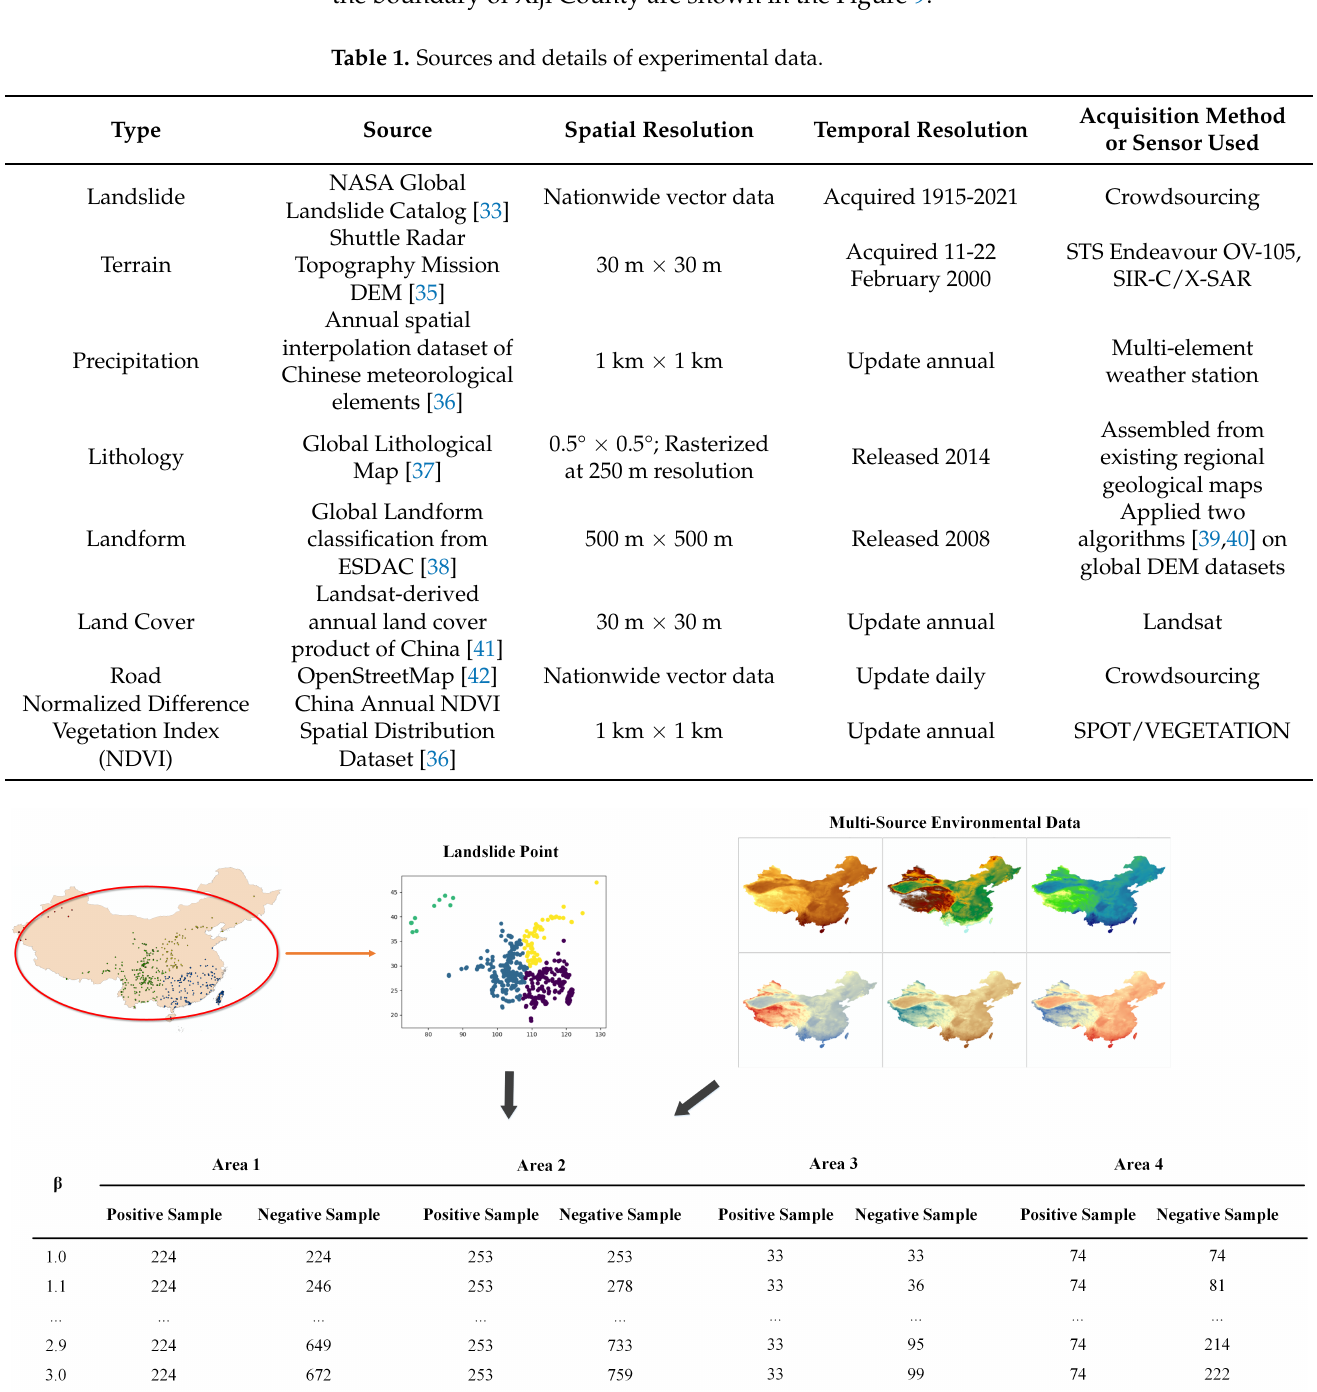
Figure 8. Template for completing phase reasoning from multiple events, and three types of rules, including one event triggering one action, event combination triggering one action, and one event triggering action